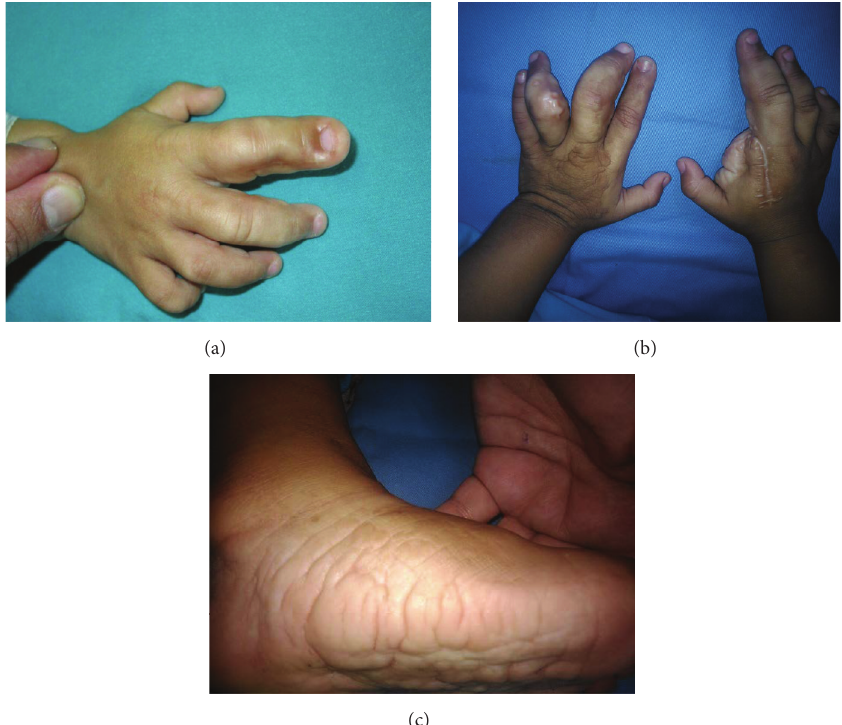
Figure 1: (a) Asymmetric overgrowth of the second finger of right hand. (b) After finger amputation. (c) Cerebriform connective tissue nevus of foot.